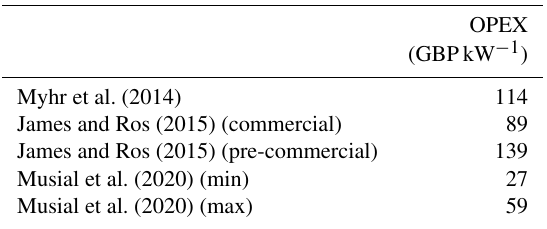
Table 6. O&M cost estimations from various reports for compari- son with the results from